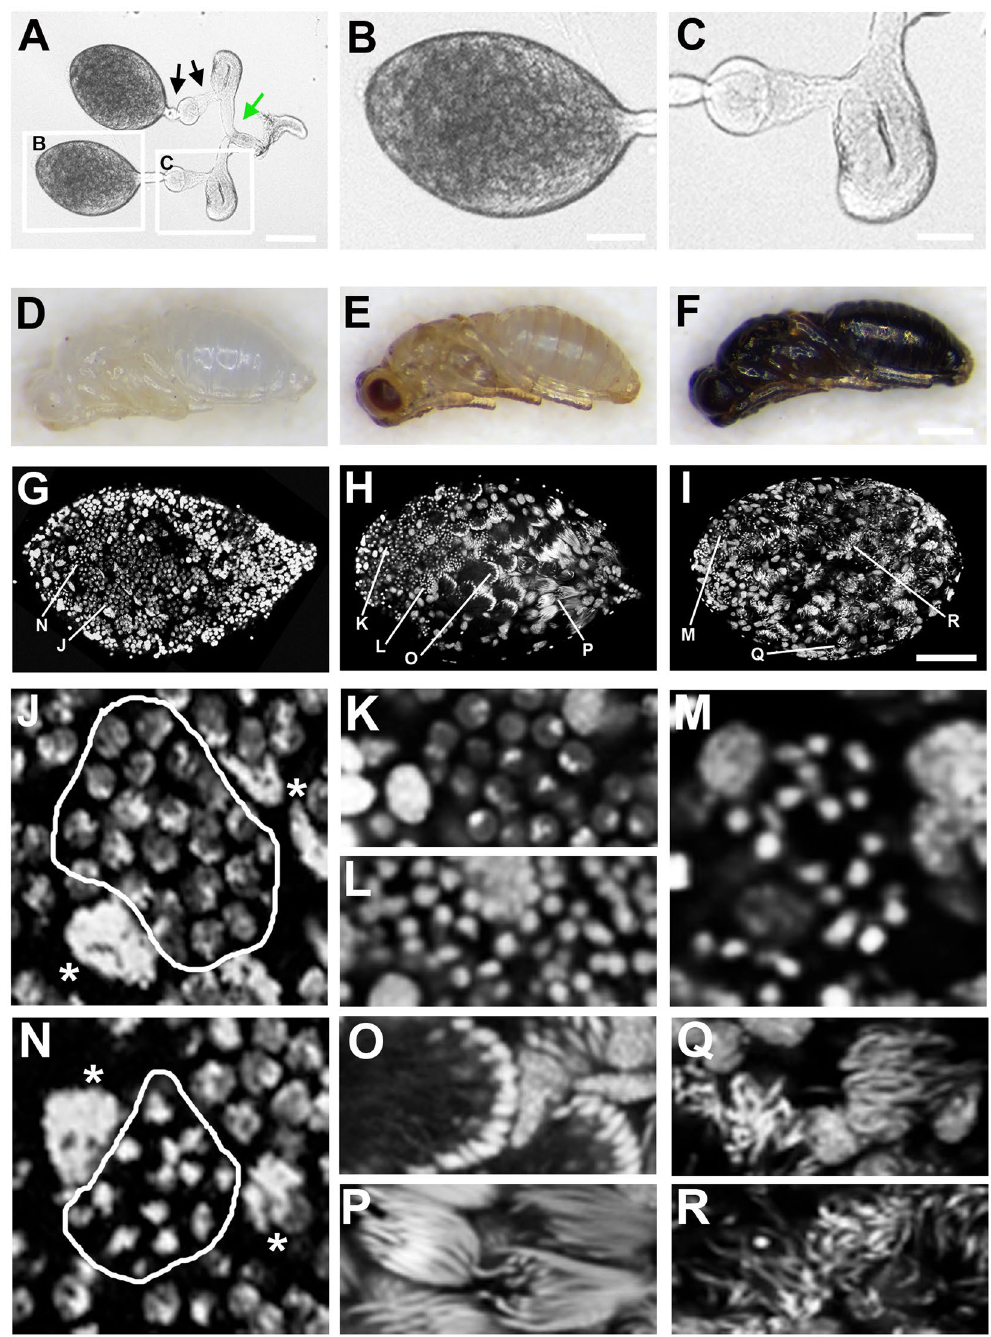
Figure 1. Male reproductive tract and cells within the testis of N . vitripennis . The bilaterally symmetrical male reproductive tract is shown in ( A ), with the testis ( B ) and seminal vesicle and accessory gland ( C ) shown at higher magnification. In ( A ), the black arrows indicate ducts joining the testis with the seminal vesicle, and the seminal vesicle with the accessory gland, while the green arrow depicts the ejaculatory duct. ( D – F ) Three major pupal stages are shown: ( D ) white body stage; ( E ) yellow body/red eye stage; ( F ) fully pigmented black body stage. ( G – I ) Fixed testes from these three pupal stages shown at low magnification. Panels (J–R) are high magnification images taken from the three testis shown in ( G – I ), with all images pertaining to each testis shown below each testis’ column. ( J ) Spermatogonia at interphase. Circumscribed cystocytes are in interphase. ( N ) Spermatogonia with condensed chromosomes. The chromatin of circumscribed cystocytes appear condensed into chromosomes. Asterisks in ( J , N ) denote trophocyte nuclei. ( K ) Small cyst of spermatogonia at interphase. ( L ) Large cyst of germ cells with condensed nuclei, indicating their entry into spermiogenesis. ( O ) A cyst forming a ‘cup-like’ structure at the onset of spermiogenesis. ( P ) Bundles of elongating spermatid nuclei. ( M ) Germ cells beginning spermiogenesis but not yet in the ‘cup’ formation. ( Q , R ) fully elongated sperm nuclei. DNA is grey in panels (G–R). White arrows indicate trophocytes. Scale bar equals 150 μ m in ( A ), 60 μ m in ( B ), 75 μ m in ( C ), 500 μ m in ( F ), and 80 μ m in ( I